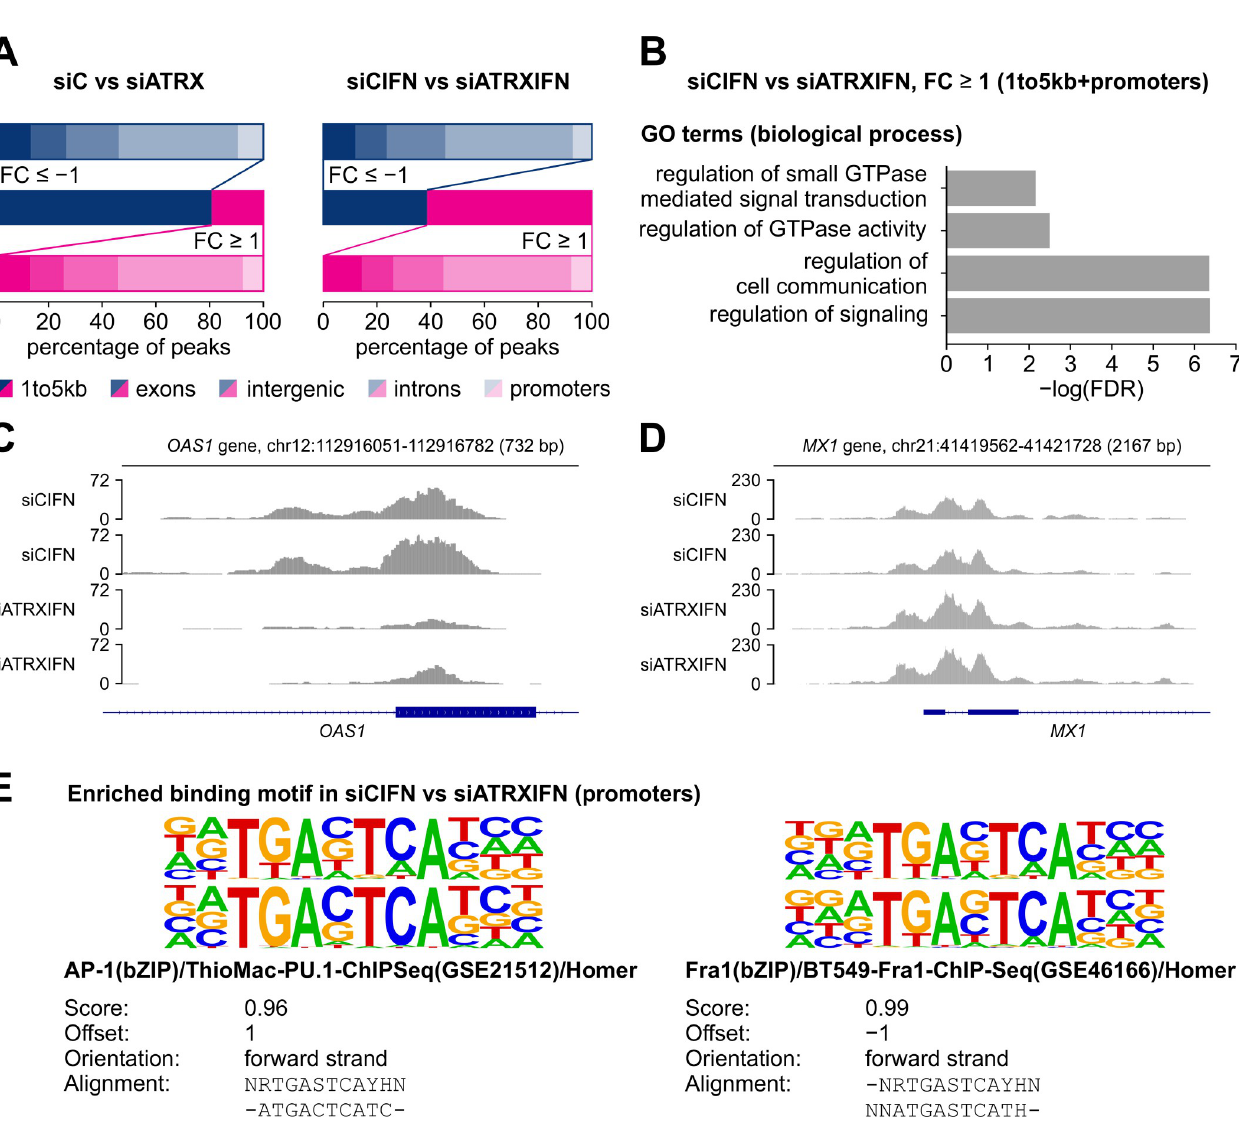
Fig 8. Annotation of differentially open chromatin in stable ATRX knockdown HFFs stimulated with IFN- β . (A) Gene annotations of regions with a FC � 1 or a FC � − 1 in the comparison siC vs siATRX and siCIFN vs siATRXIFN. (B) GO-enrichment analysis of genes annotated to regions 1 to 5 kb prior to a TSS and promoter regions with a FC � 1 in the comparison siCIFN vs siATRXIFN. Analysis was performed using the Gene ontology database. (C+D) Exemplary Integrative Genomics Viewer (IGV) tracks of the region annotated to (C) OAS1 showing less accessible chromatin in siATRX cells and (D) MX1 showing no change in chromatin accessibility. Both duplicates of the samples siCIFN and siATRXIFN are shown. (E) Homer de novo motif analysis of peaks annotated to promoter regions of the comparison siCIFN vs siATRXIFN. The top motif (p-value of 10 − 103 ) is shown (top) aligned with the matched known motifs